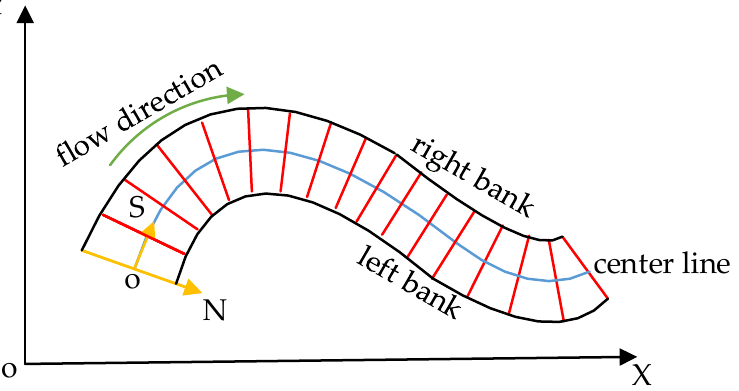
Figure 1. Schematic diagram of the reference system (S, N). The blue lines represent the center line of the river, and the red lines represent section lines. In the reference system (S, N) represented by yellow, the S axis coincides with the center line of the river channel, and the water flow direction represented by a green arrow is positive. The N axis is perpendicular to the S axis. The upstream and downstream flow can be judged according to the direction of the S axis, and the left and right banks can be judged according to the direction of the N axis.